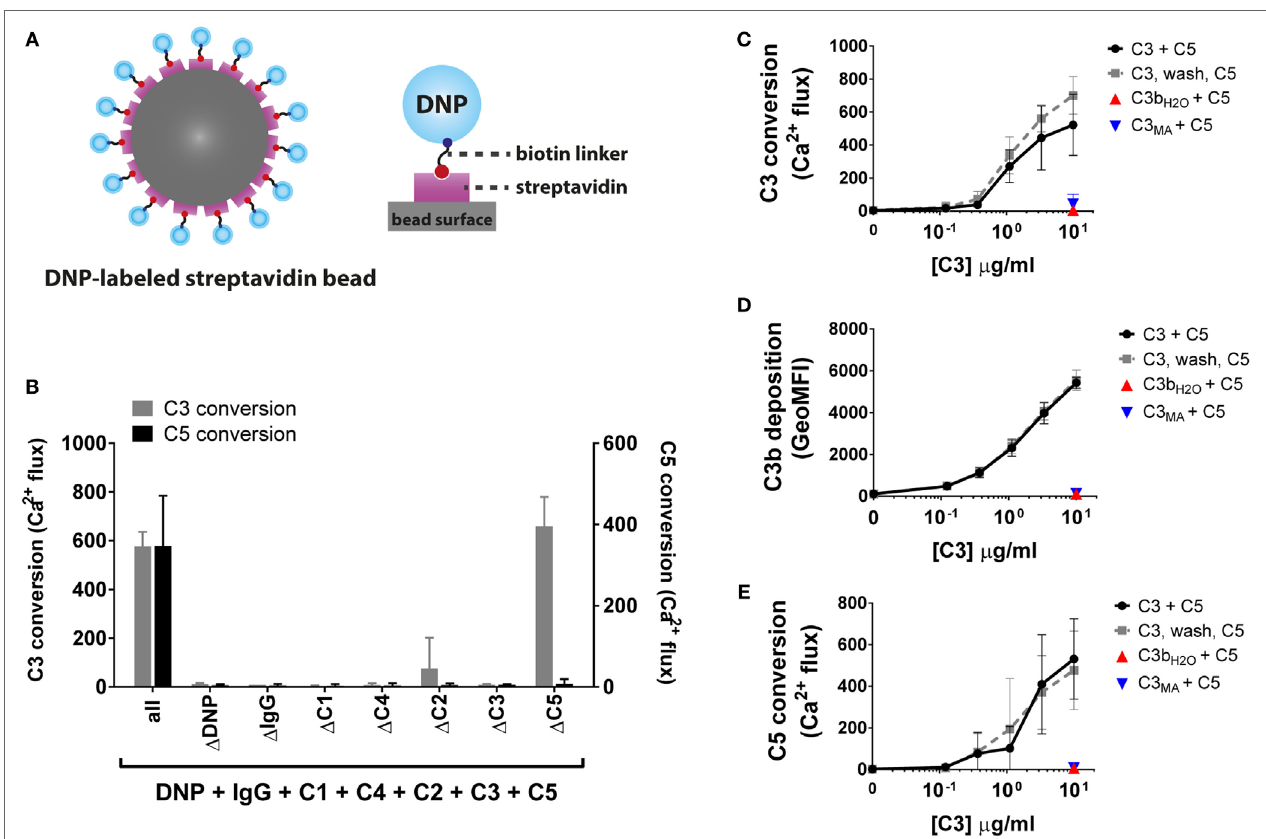
FigUre 4 | Development of a classical pathway C3 and C5 convertase model. (a) In the CP convertase model, streptavidin beads are labeled with biotinylated DNP which serves as a model antigen. Addition of IgG1 recognizing DNP and complement proteins results in formation of C4b2a and C4b2a(C3b) n convertases on the bead surface, which convert C3 and C5. (B) Only in the presence of all CP components (antigen, IgG, and CP proteins) C3 and C5 are converted, as measured by calcium mobilization in U937-C3aR and U937-C5aR cells, respectively. (c) C3 conversion via CP convertases results in release of C3a in the supernatant (as shown by calcium mobilization) and (D) C3b deposition on the bead surface (as shown by flow cytometry). Identical amounts of the non-reactive C3 variants C3b H2O and C3 MA do not bind to the bead surface. (e) C5 convertase activity increases with the level of deposited C3b molecules on the beads surface, but is not affected by C3b H2O or C3 MA in solution. Uncoupling C3 and C5 conversion by introduction of an extra washing step does not alter C5 conversion, indicating that CP C5 conversion only depends on deposited C3b molecules around existing C3 convertases. (B–e) Data of three independent experiments, presented as mean ±